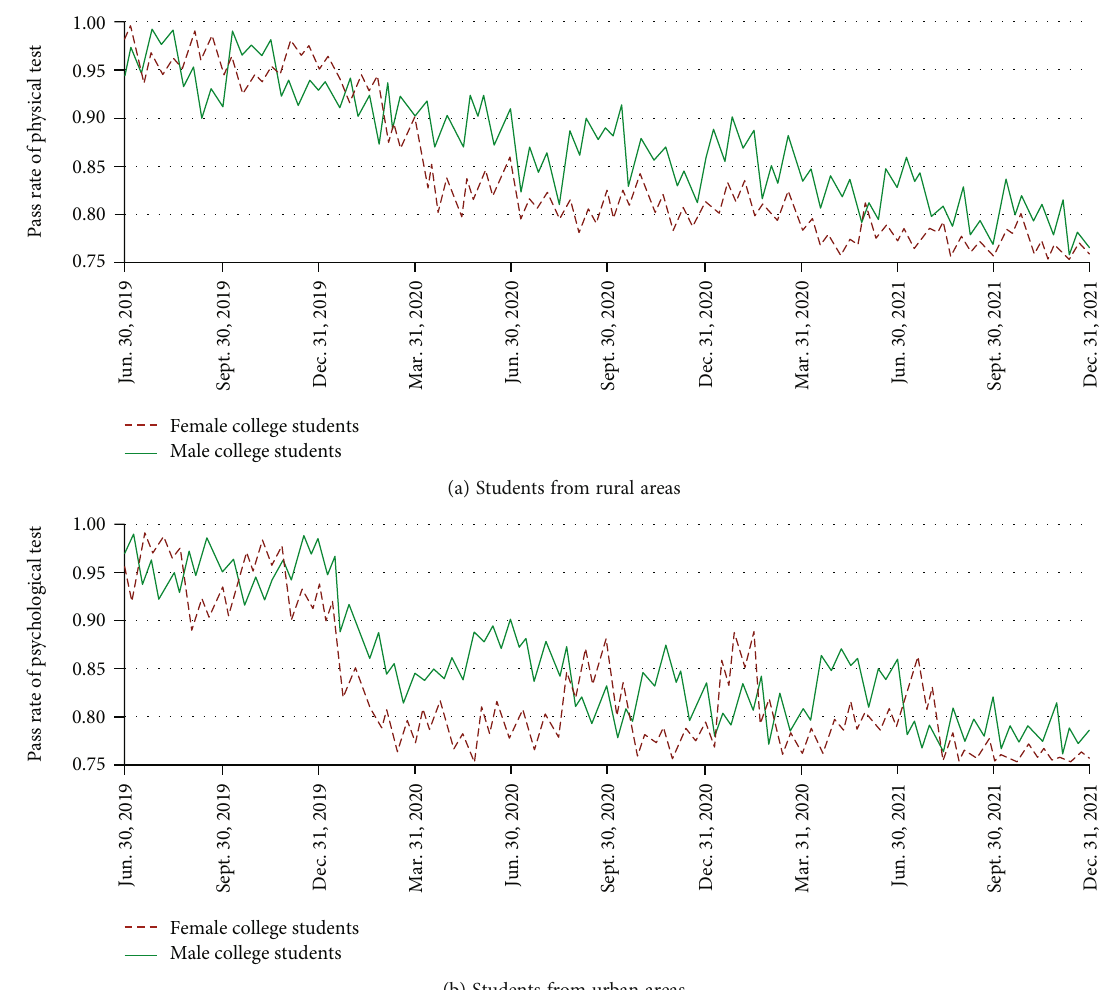
Figure 5: Physical exercise and psychological changes of college students from rural (a) and urban (b) areas before and after the intervention based on multidimensional data